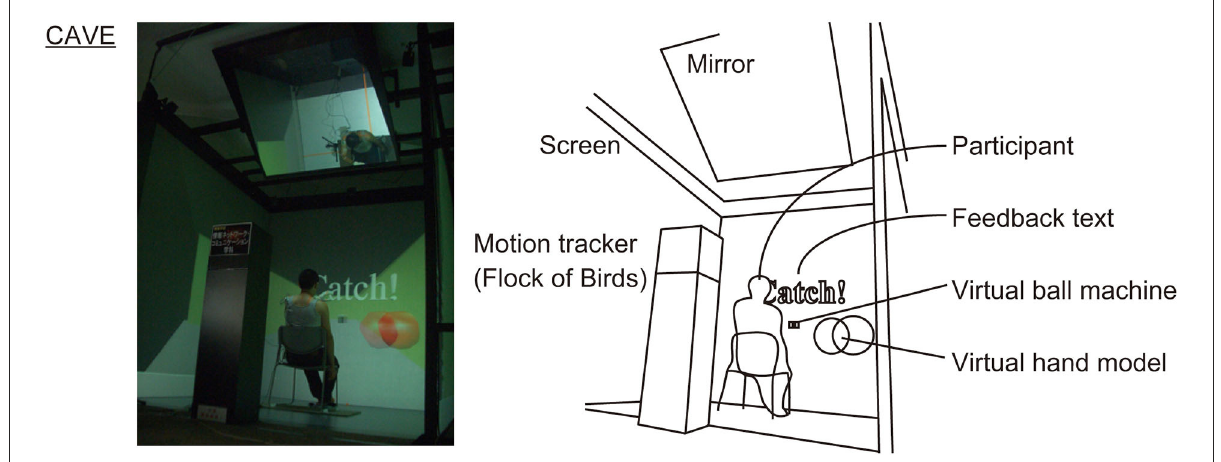
FIGURE2 The VR experiment using CAVE. The virtual hand model and feedback text “Catch!” were invisible during trial. The feedback text was temporarily displayed after successful trials.